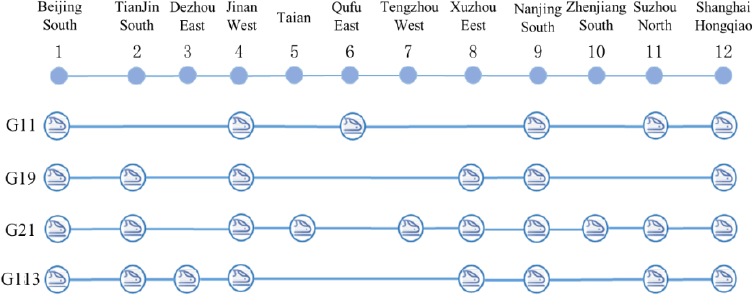
Figure 5. Average demand density proportion of several OD pairs. The highest (corresponding to the published price) and lowest price discounts are 1 and 0.56, respectively, and we take the interval of 0.04 to define the price discount coeffi- cient set 𝜷 = {0.56, 0.60, … , 0.96, 1} . According to Qi et al. [35], we have 𝜈 = 0.6 yuan/mi- nute and 𝜃 = 0.012. For the CSA algorithm, 𝐼 1 = 7920 , 𝐼 2 = 400 , 𝛼 = 0.95 , 𝑇 𝑚𝑖𝑛 = 0.001 , and 𝜏 = 100 . 5.2. Results and Analysis We used the Python programming language to implement the algorithm and solve the model. Figure 6 presents the iteration process of the CSA algorithm. The objective value starts to converge around 130 iterations and remains unchanged thereafter.